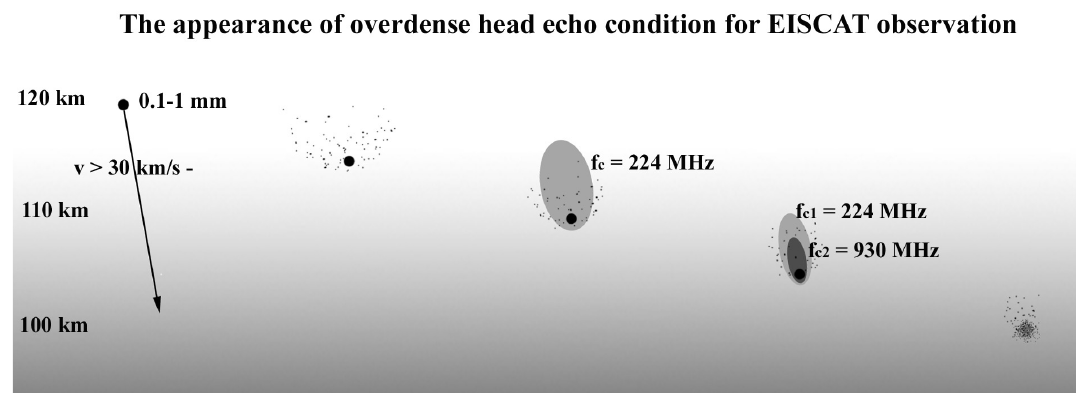
Fig. 1. The meteoroid-atmosphere interaction model based on EISCAT dual frequency observations. The ionized target becomes observable for the EISCAT 224MHz VHF radar when it reaches the overdense condition at about 110km. Some six kilometers further down, the effect of further ionization and increased atmospheric density compresses the target to reach the overdense condition, even for the EISCAT 930MHz UHF radar waves. As the VHF waves do not reach as deep in the target as the UHF, the VHF target is slightly larger than the UHF one. If the geocentric velocity of the meteoroid is 50 km/s, every step in the process occurs with a 0.1-s interval. (Adapted from Pellinen-Wannberg,